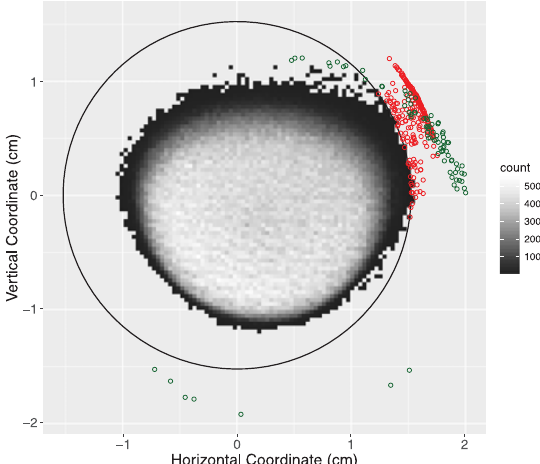
Figure 6. Results from the proton focusing simulation. The black circle indicates the active region of the detector. Gray pixels are protons that struck the active region (99.97%). Red circles are protons that struck an inactive part of the detector (0.02%). Green circles are protons that struck the focusing ring (0.008%). An additional 0.002% missed the proton detection assembly and were